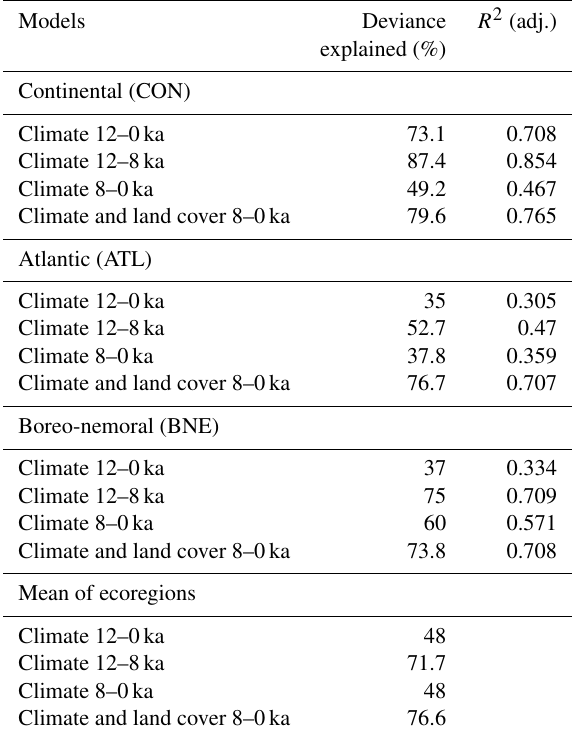
Table 1. Goodness of fit (deviance) and R 2 adjusted for each ecore- gion, including climate conditions only for the following